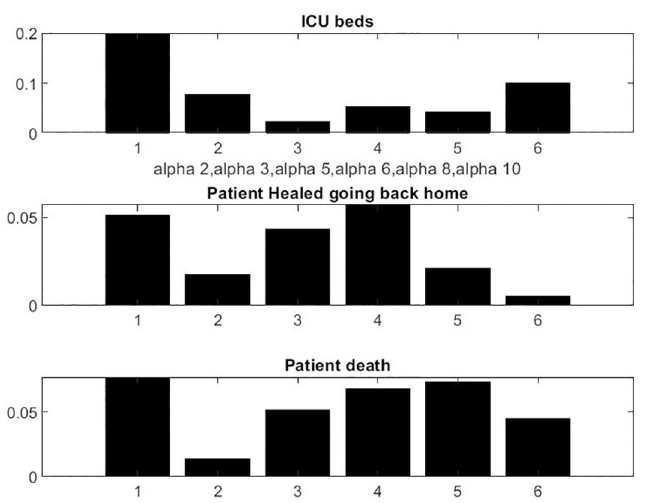
Fig 3. Linear sensitivity with respect to parameters [ α 2 , α 3 , α 5 , α 6 , α 8 , α 10